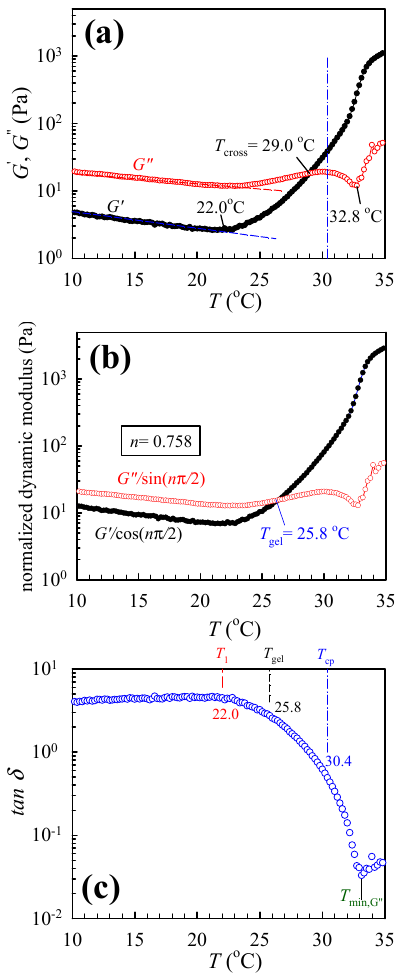
Figure 3. ( a ) Dynamic storage modulus G (cid:48) and loss modulus G (cid:48)(cid:48) of the 12 wt% a-PNIPAM aqueous solution during temperature sweep test, ( b ) the normalized curves of G (cid:48) and G (cid:48)(cid:48) with respect to a critical relaxation exponent n of 0.758, and ( c ) the loss tangent (= G (cid:48)(cid:48) /G (cid:48) ). Both the T cross and T min,G” are displayed. The dashed lines are for the eye-guide to illuminate the onset of upturn in G (cid:48) and G (cid:48)(cid:48) vs. T . T cp determined from the turbidity measurement is shown by the dash-dot line. The values of G (cid:48) at T cross are 2 and 18 Pa for the 7 and 12 wt% solutions, respectively. These values are approximately two orders of magnitude lower than the modulus